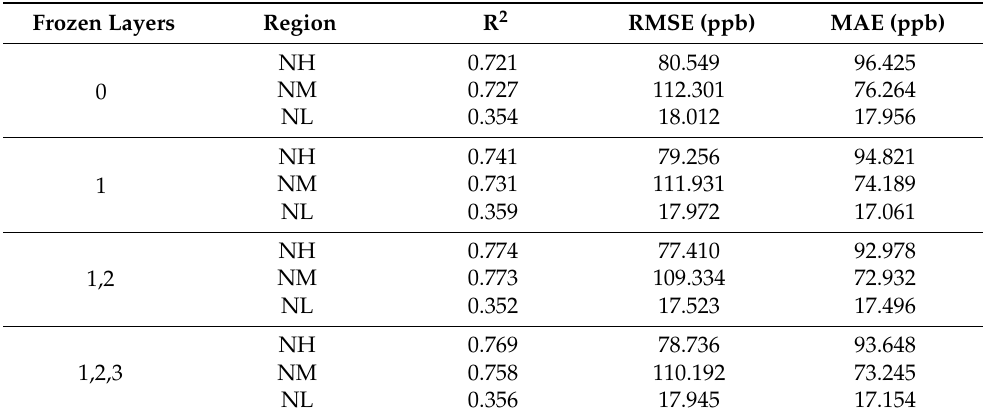
Table A2. Prediction performance of migration model under different frozen hidden layers of CARIBIC in NH, NM, and